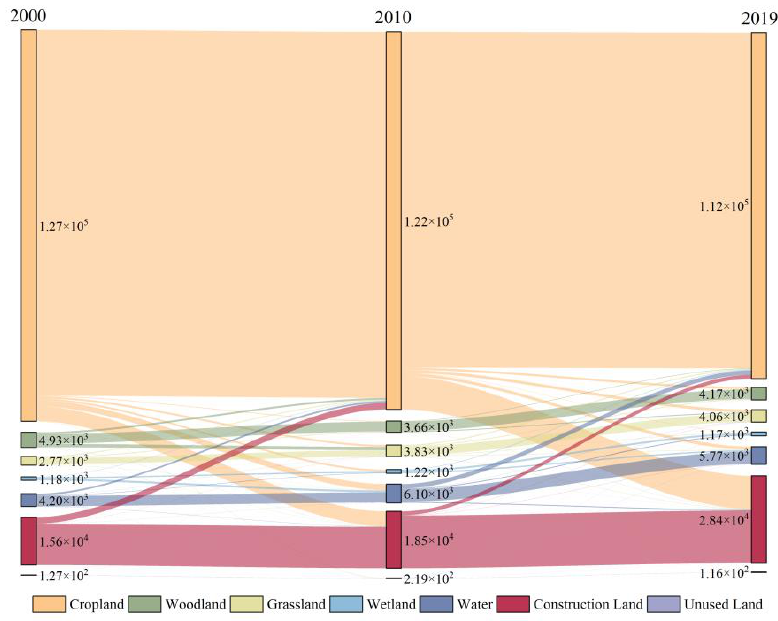
Figure 2. Transfer process of each land use type in Shandong Peninsula urban agglomeration from 2000 – 2019 (unit: km 2 ). 2000–2019 (unit: km 2